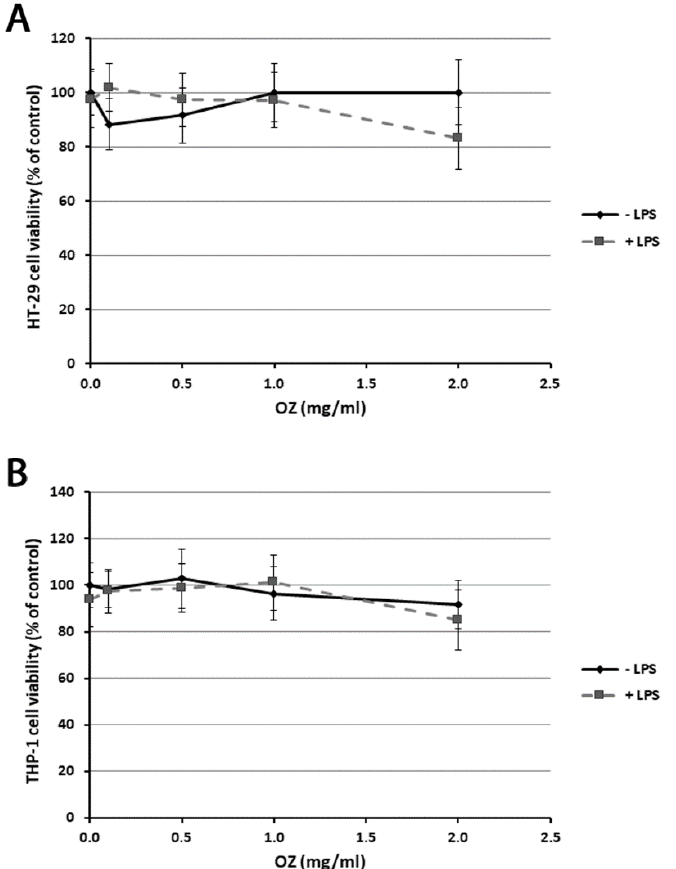
Figure 1. Effects of Ozoile (OZ) on HT − 29 ( A ) and THP − 1 ( B ) cell viability in the presence or absence of LPS (1 µg/mL). Different concentrations of Ozoile (0.1, 0.5, 1 and 2 mg/mL) were added to the culture medium 30 min before LPS treatment (1 µg/mL for 4 h), and then cell viability was assessed by the MTT test. Results are expressed as percentages relative to untreated cells. Data are means ± SEM from five independent experiments.